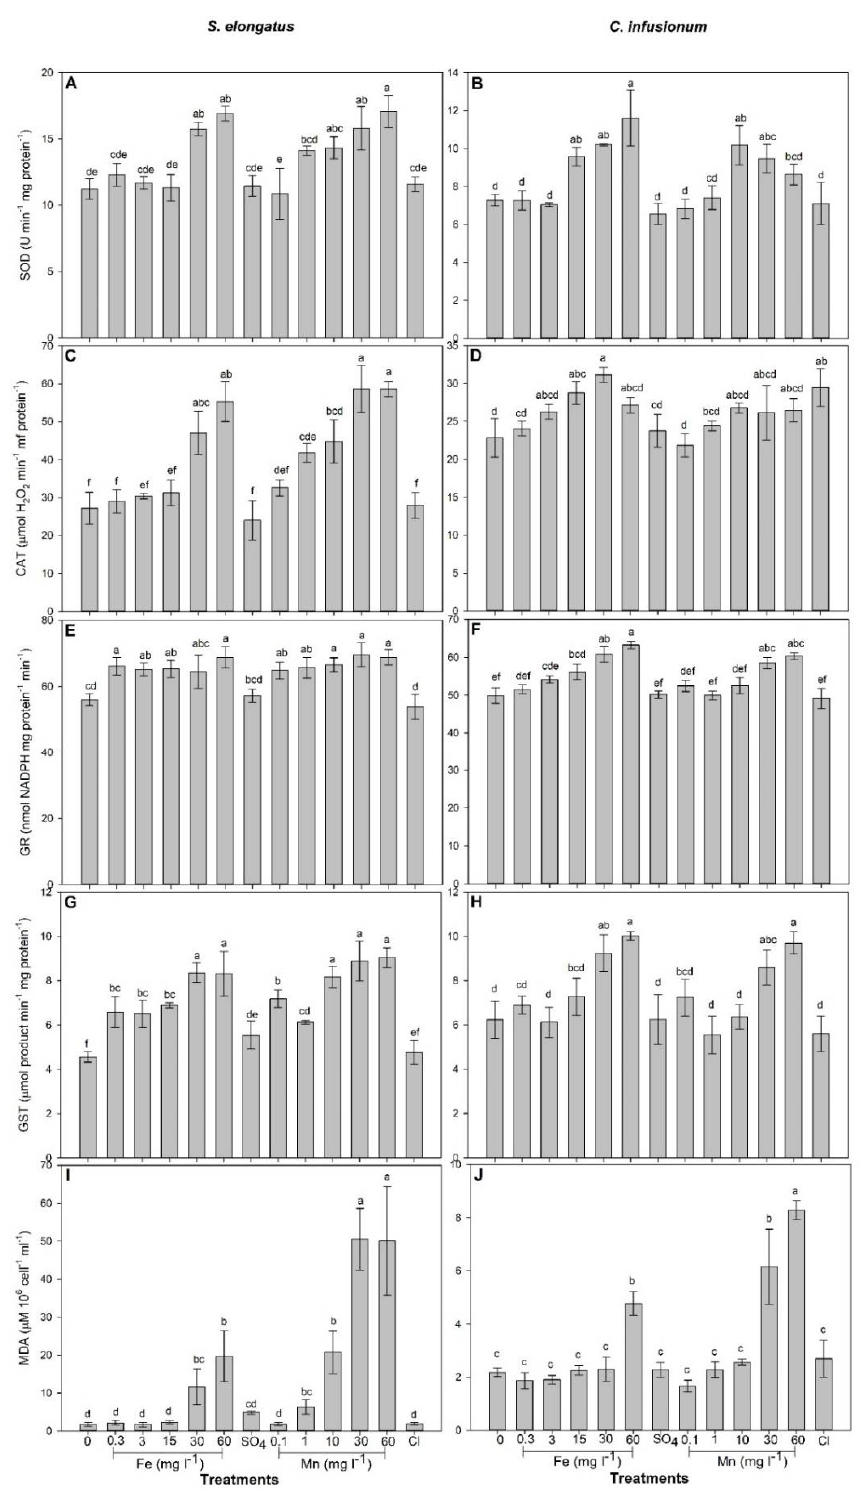
Figure 2. The activities of superoxide dismutase (SOD) ( A and B ), catalase (CAT) ( C and D ), glutathione reductase (GR) ( E and F) , glutathione- S -transferase (GST) ( G and H ), and the concentration of malondialdehyde (MDA) ( I and J ) in Synechococcus elongatus and Chlorococcum infusionum cells exposed to increased concentrations of Fe or Mn (mg L − 1 ) or to 103.20 mg SO 4 L − 1 and 77.45 mg Cl L − 1 for 96 h. Bars represent means ± SD of three replicates. Different letters indicate significant difference ( p > 0.05) by the post hoc Tukey